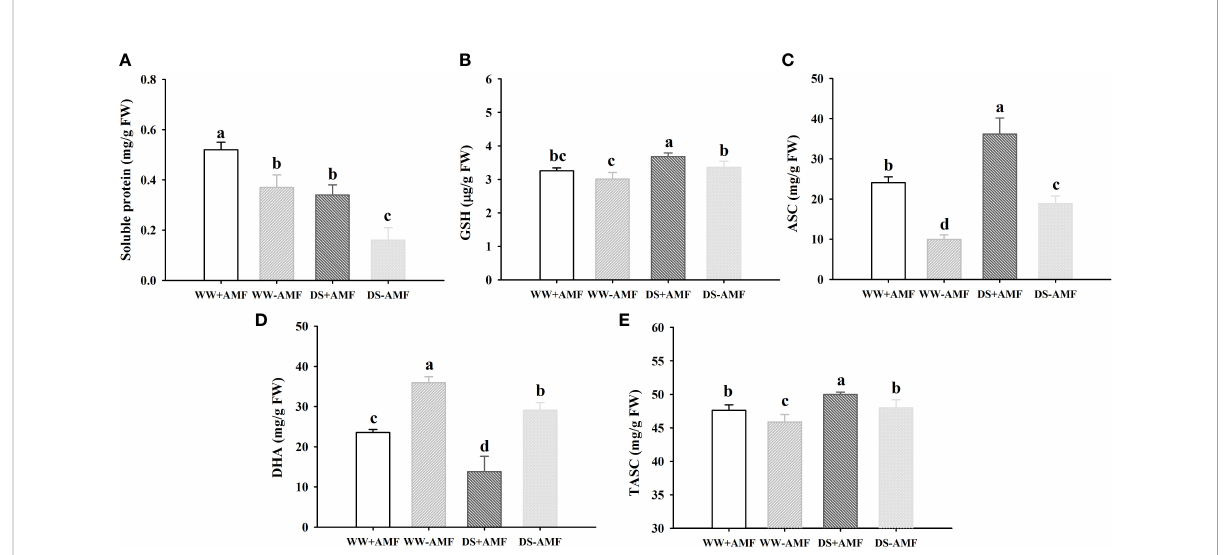
FIGURE 3 Effect of AMF ( Diversispora spurca ) on leaf soluble protein (A) , GSH (B) , ASC (C) , DHA (D) , and TASC (E) concentrations of walnut under well-watered (WW) and drought stress (DS). Data (means ± SD, n = 4) are signi fi cantly different ( P < 0.05), iffollowed by different letters above the